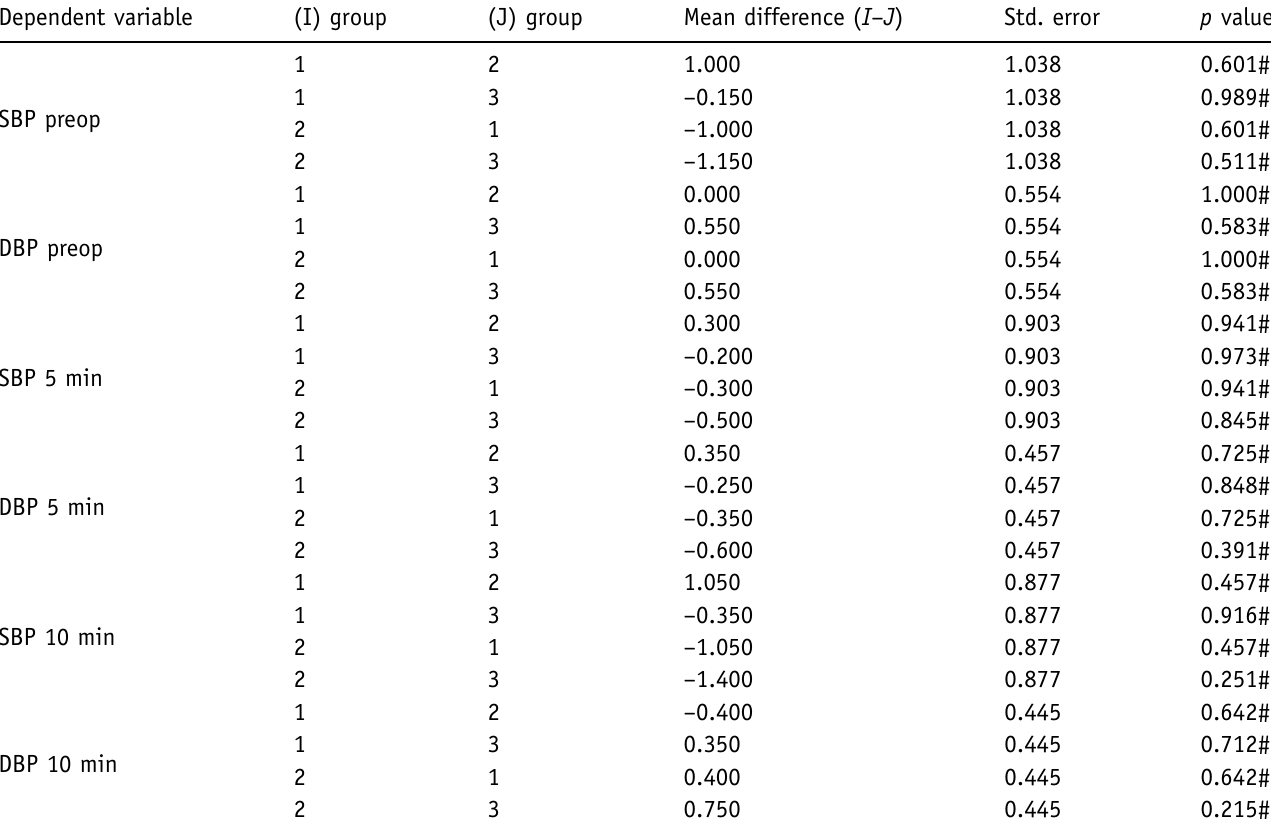
using Post Hoc 2